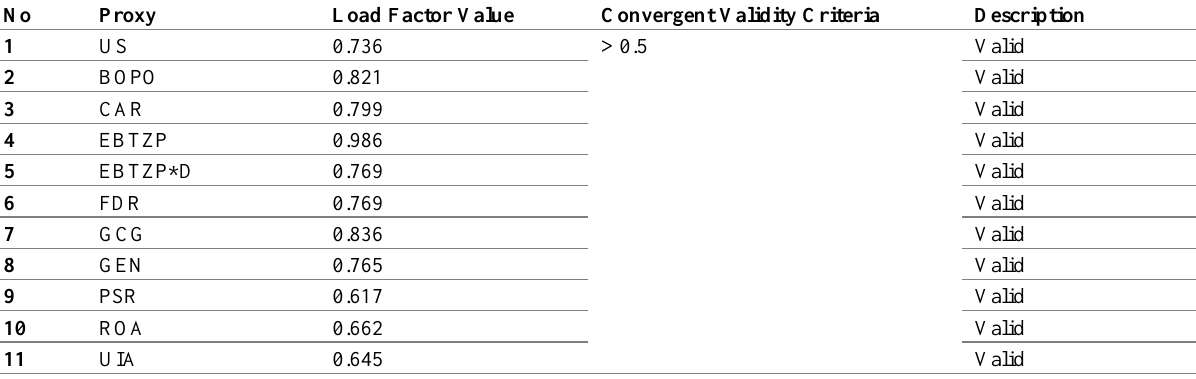
Table 2: Value of Loading Factor